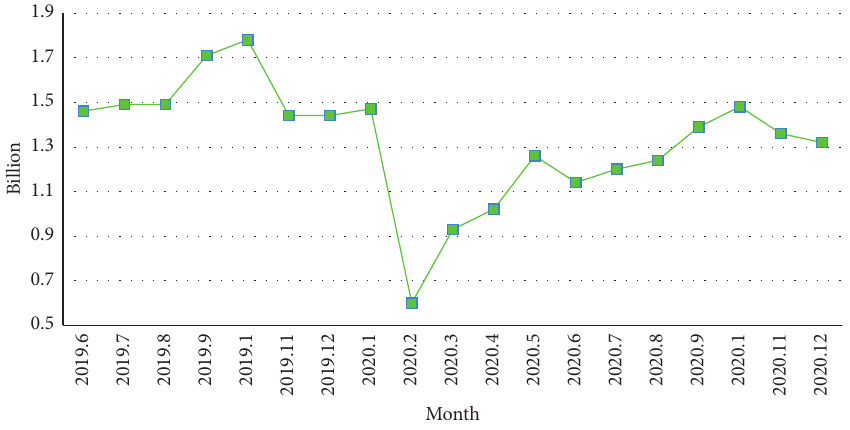
Figure 2: Number of apps visited in